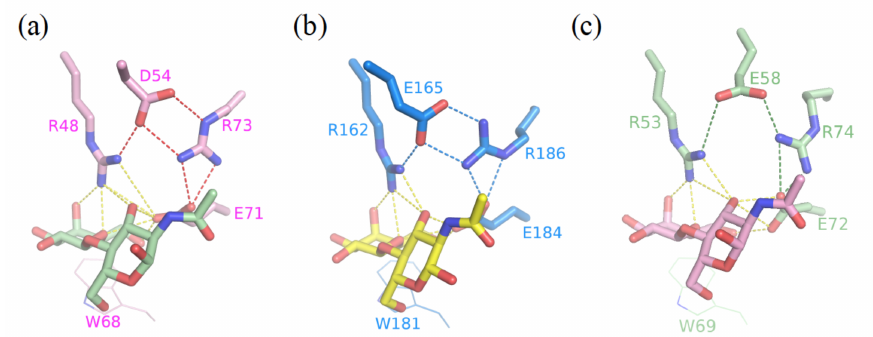
Figure 11. Structures of ( a ) GAL-1 (PDB ID: 1W6P), ( b ) GAL-3 (1KJL), and ( c ) GAL-7 (5GAL) in complex with LacNAc. The salt bridges between Asp/Glu and Arg in LacNAc complex structures are shown in dotted lines for GAL-1 (red), -3 (marine blue), and -7 (forest green), respectively, and all interactions related to galectin–LacNAc complexes formation are colored in